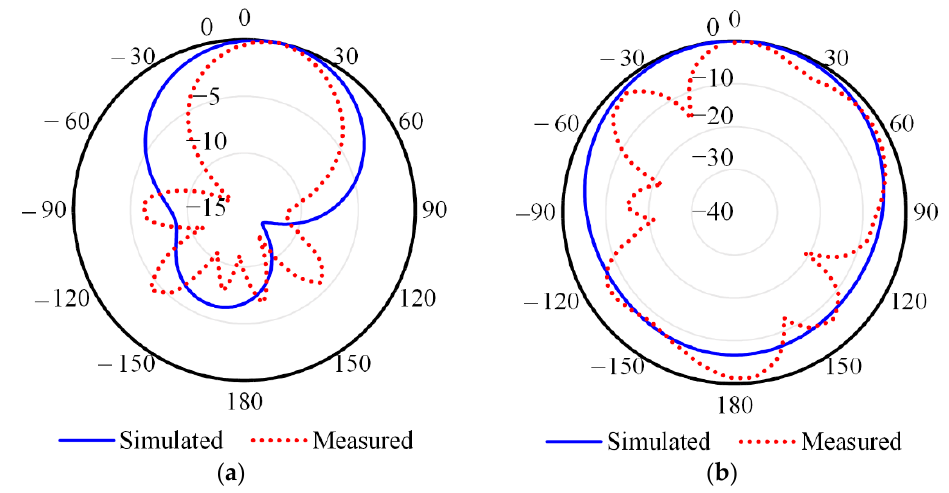
Figure 22. The simulated and measured radiation pattern of the single band antenna (using low-cost FR-4 substrate) at 2.4 GHz on ( a ) E-plane and ( b ) H-plane.